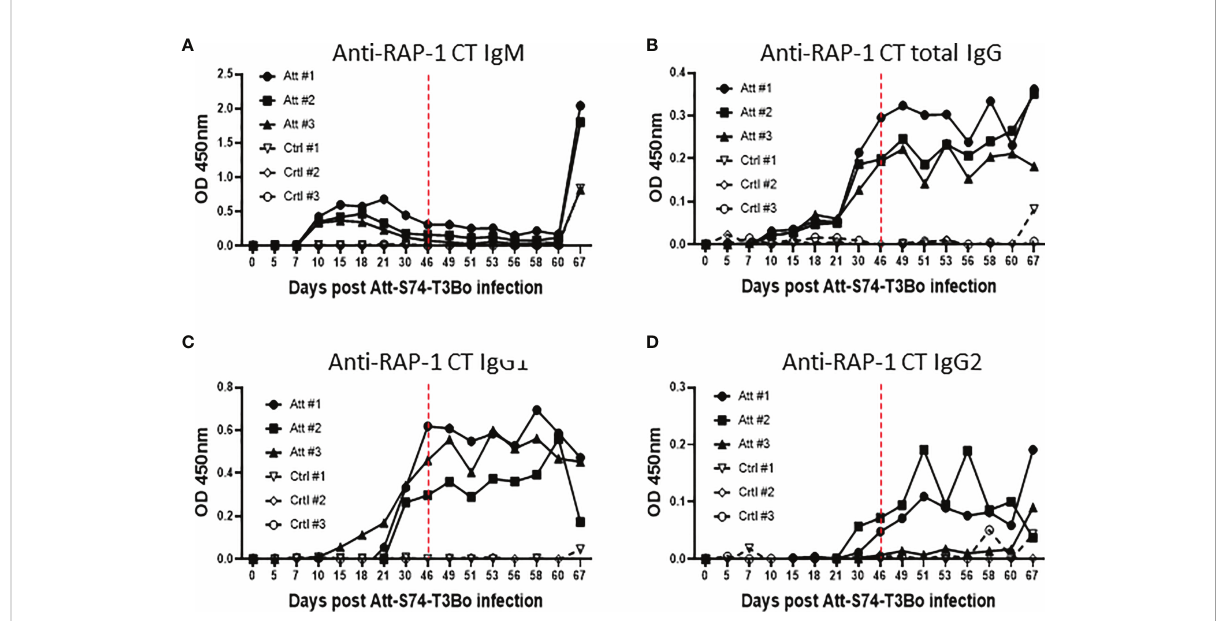
FIGURE 5 Humoral immune response accessed by indirect ELISA using the immunodominant antigen rhoptry associated protein 1 C-terminal (RAP-1 CT) after infections with the in vitro culture attenuated B. bovis strain Att-S74-T3Bo and the virulent B. bovis strain Vir-S74-T3Bo. Anti-RAP-1 CT IgM